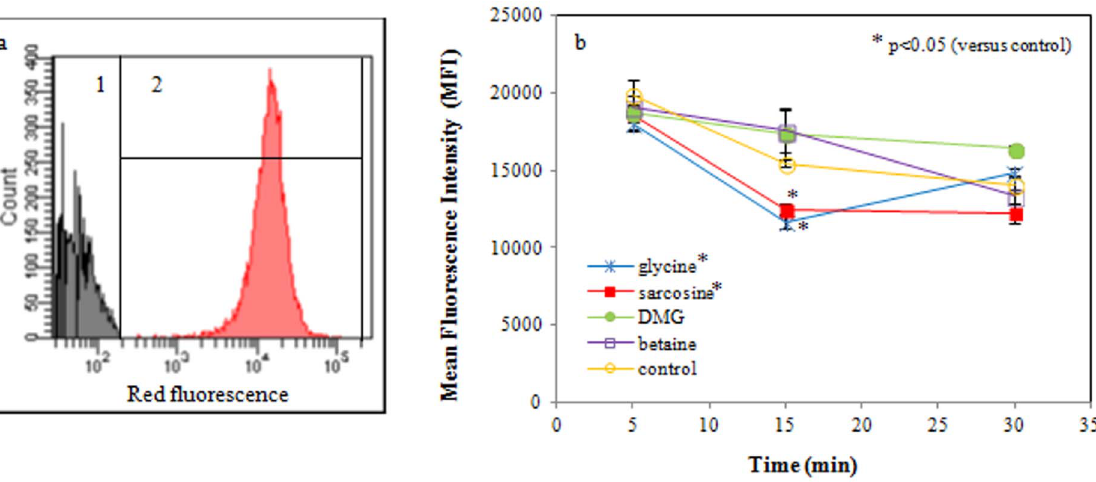
Figure 8. Overlay diagram of the flow cytometric histograms representing respiratory active and inactive E. coli subpopulations (a). Inactive (1) and active (2) ETEC subpopulation are determined by CTC staining. Inactive cells do not stain because they lack respiratory dehydrogenase activity. Actively respiring cells are red fluorescent. Both populations are separated by the black line. Mean fluorescence intensity (MFI) presenting E. coli respiratory activity (b). Compared to the active control, ETEC exposed to glycine and sarcosine (50 mM, pH 9.5) showed a significant decrease in MFI after 15 min of incubation (p=0.017 and p=0.008, respectively). Data are expressed as means 6 SD of triplicate experiments.